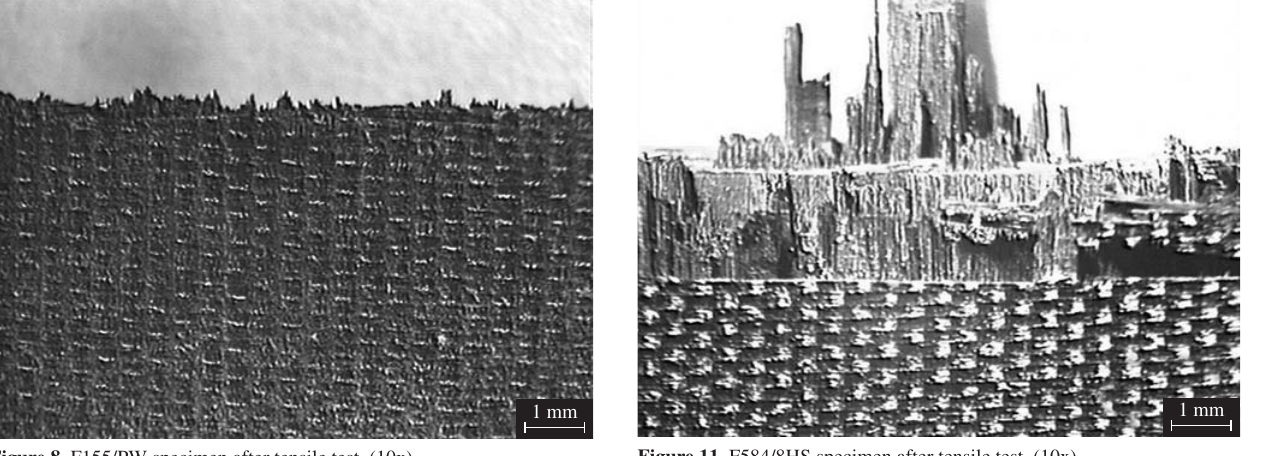
Figure 8. F155/PW specimen after tensile test, (10x).